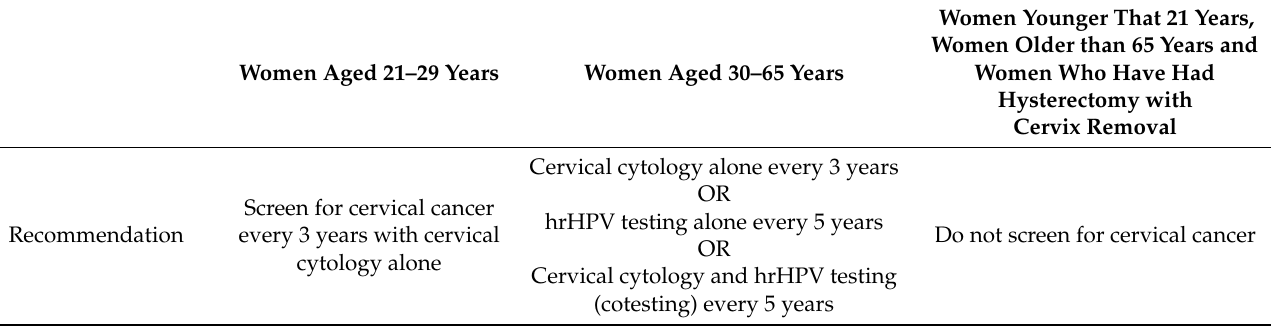
Table 2. Cervical screening recommendations